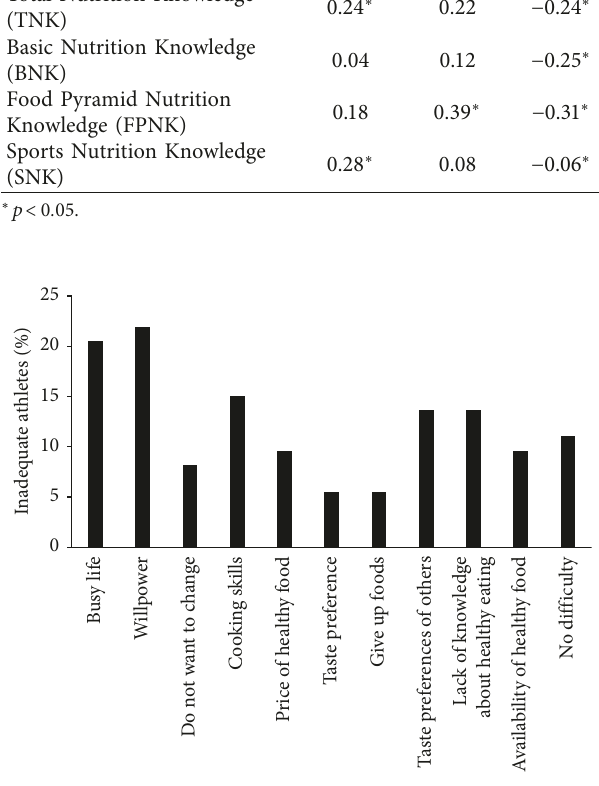
Figure 2: Athlete’s barriers in trying to eat healthy ( n